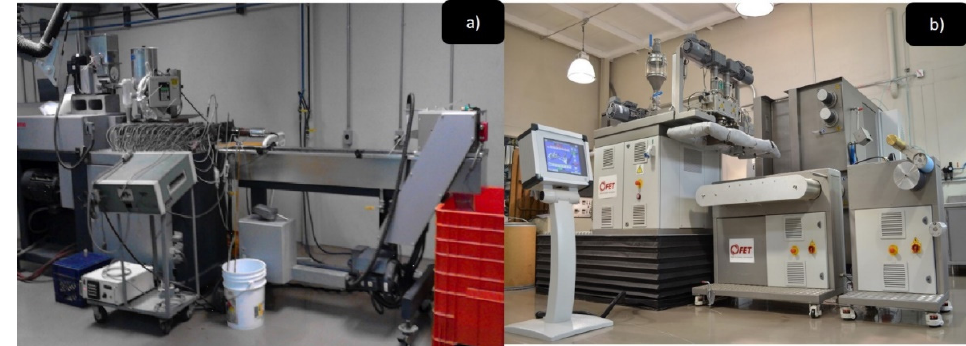
Figure 1. Images of extruders used in to manufacture nonwoven fabric: ( a ) twin-screw extruder connected to a homemade ultrasonic generator; and ( b ) fiber extrusion technology (FET-UK) pilot